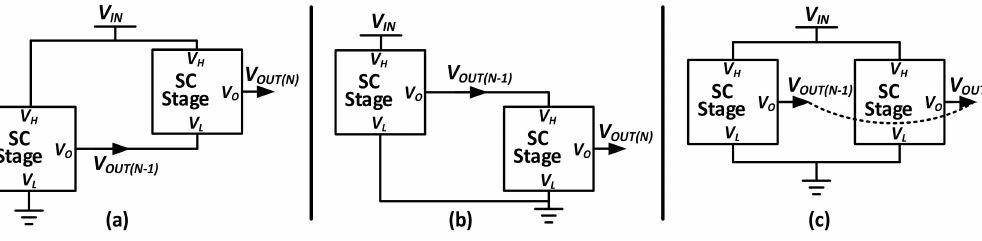
Figure 10. Figure 10 . Three possible stage interconnect operation modes: ( a ) A n B n = 00. ( b ) A n B n = 01. ( c ) A n B n = 1X. Table 3. Reconfigurable stage interconnect (RSI) control